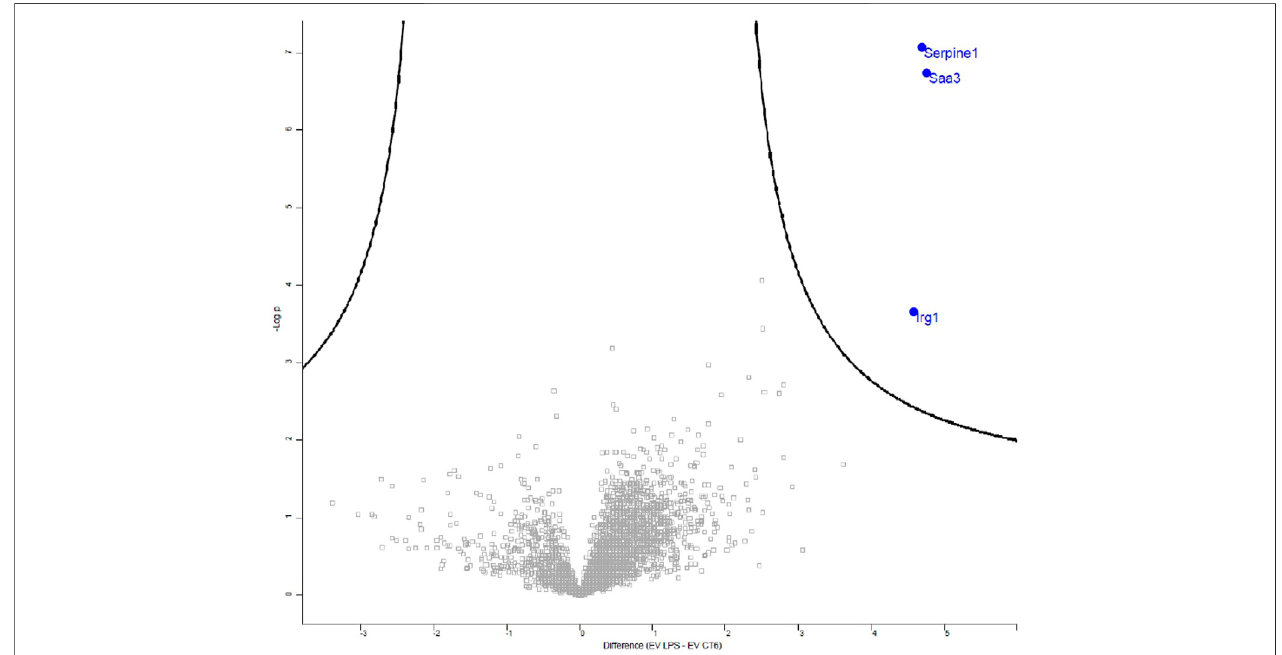
FIGURE 11 | Volcano plot representing the effects of lipopolysaccharide-EK (LPS-EK) on the protein content of macrophage-derived extracellular vesicles (EVs). EVs were isolated from the culture media of RAW cells incubated with (EV-LPS) or without (EV-CT6) lipopolysaccharide-EK (LPS-EK). High-performance liquid chromatography(HPLC)coupledtomassspectrometryanalysiswasperformed.AnunpairedStudent ’ sttestwasconductedanda p -value < 0.01andafalsediscovery rate (FDR) < 5% were used. Five independent experiments were performed.